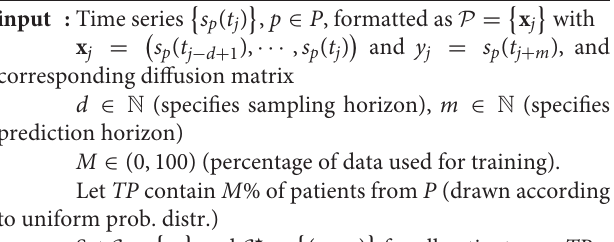
Algorithm 1 Deep Network for BG